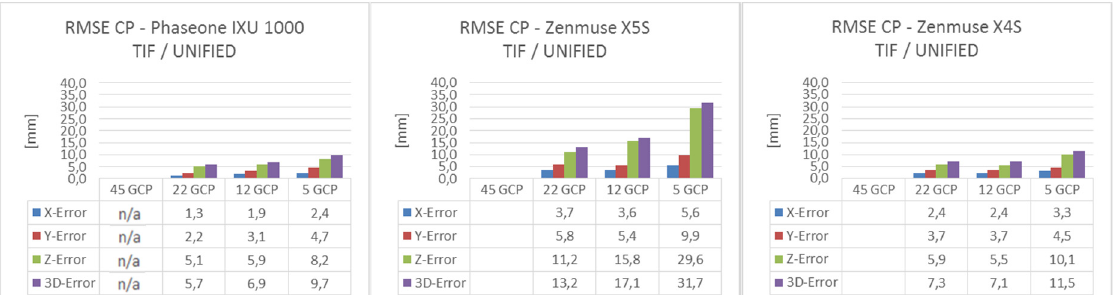
Figure 7. RMSE values at CPs. Flight arrangement: RC. ONE set of interior orientation parameters (UNIFIED). Calculation: